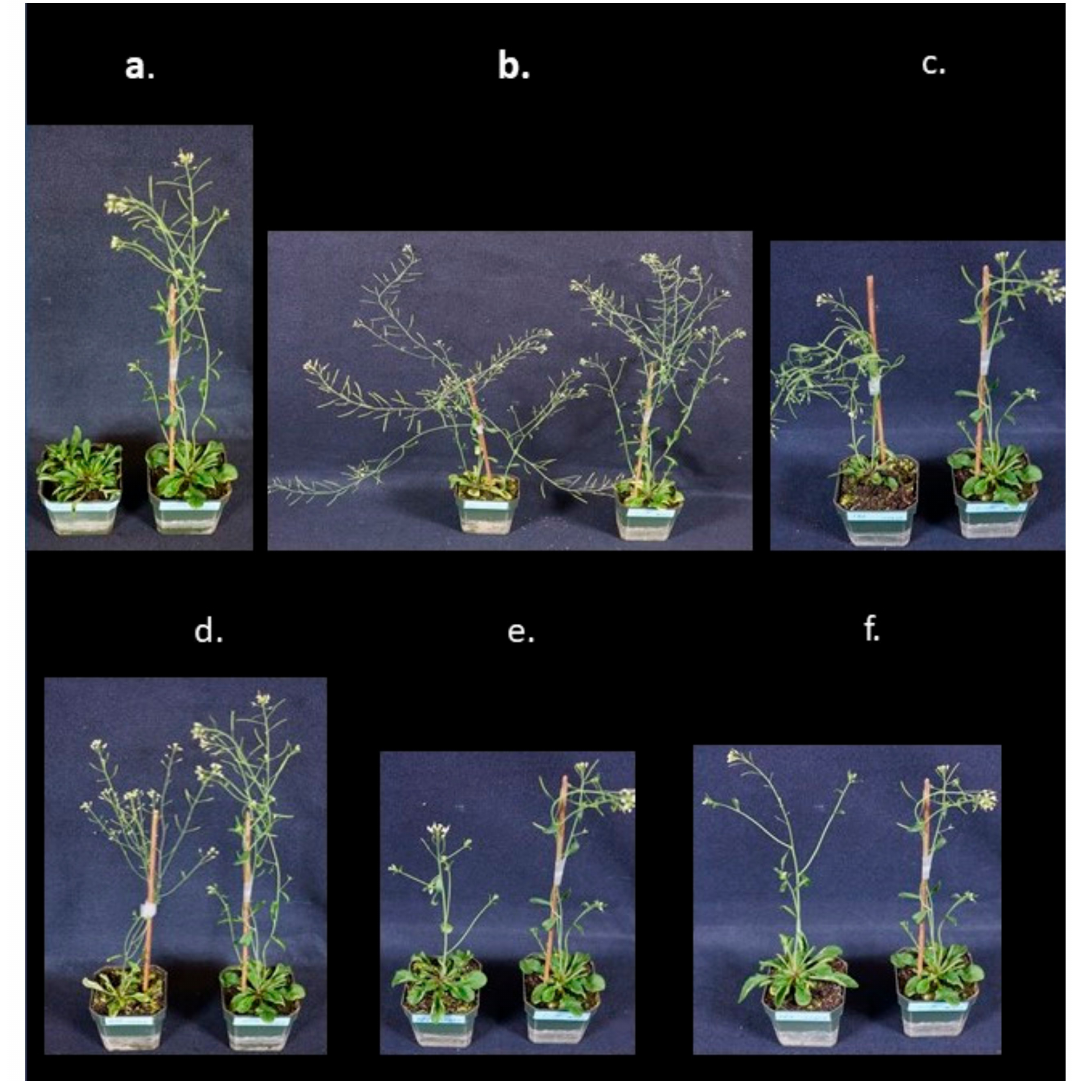
Figure 3. Morphological phenotypes of apple FOX Arabidopsis transgenic lines. C0 is nontransformed Arabidopsis ecotype Columbia 0 (C0). ( a ) Line 145, left, with delayed growth and flowering; C0, right. ( b ) Line 167, left, with thick stem, wide branch angles and long branches; C0, right. ( c ) Line 186, left, with spindly stem and small leaves; C0, right. ( d ) Line 216, left, with spindly stem and tiny leaves; C0, right. ( e ) Line 236, left, with short, thick stem; C0, right. ( f ) Line 263, left, with thick, tall stem and few flowers; C0,